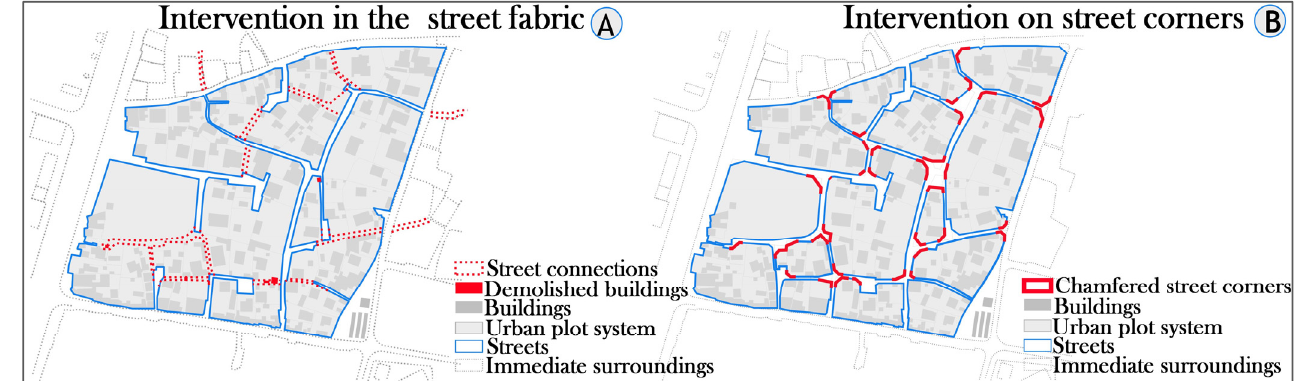
Figure 11. Activating the physical and visual permeability of the organic street system.